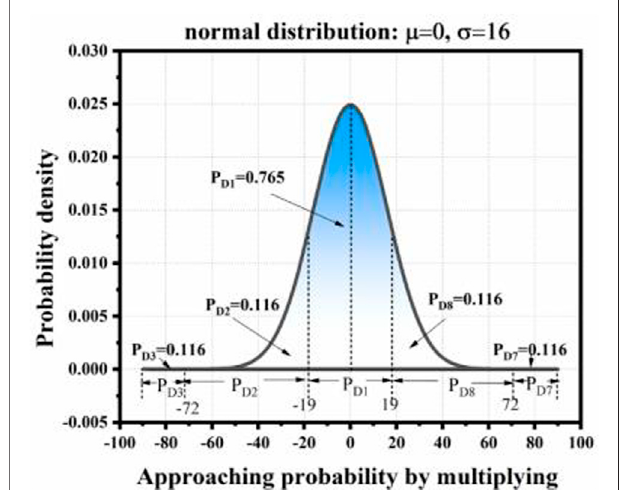
FIGURE 16 | Entering and leaving a cell in multiple directions.